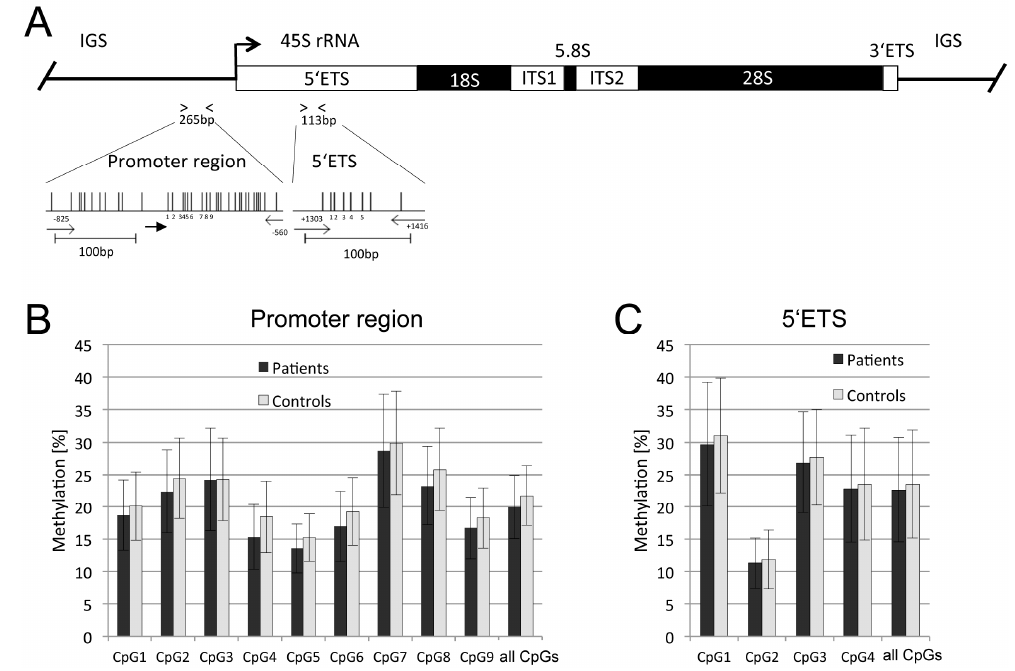
Figure 1. Methylation analysis of rDNA in blood from borderline personality disorder (BPD) patients and control persons. ( A ) Map of a human rRNA gene. The transcription start site of the 45S rRNA is marked with an arrow; The rRNA gene is organized in 5 ′ external transcribed spacer (5 ′ ETS), 18S rRNA , internal transcribed spacer 1 ( ITS1 ), 5.8S rRNA , ITS2 , 28S rRNA , 3 ʹ ETS and intergenic spacer (IGS). PCR products for bisulfite sequencing are depicted. Individual CpGs are indicated by vertical lines and the analyzed CpGs for each region are numbered. Primers are marked with arrows. Graphics were generated with the Python vs. Cobra program (https://launchpad.net/python.vs.cobra) and scale bars indicate 100 bp. Methylation levels of nine CpGs located in the distal promoter ( B ); and four CpGs in the 5 ′ ETS ( C ) were obtained by bisulfite pyrosequencing. CpGs indicate the mean methylation of the analyzed region.